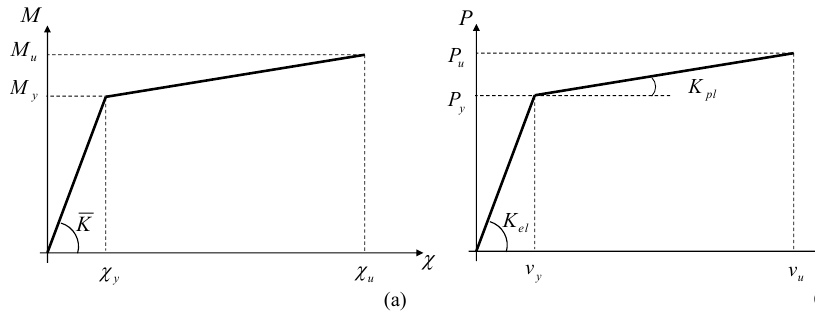
Figure 5. Bending moment–curvature relation (a) and load–displacement relation of the SDOF model (b) .